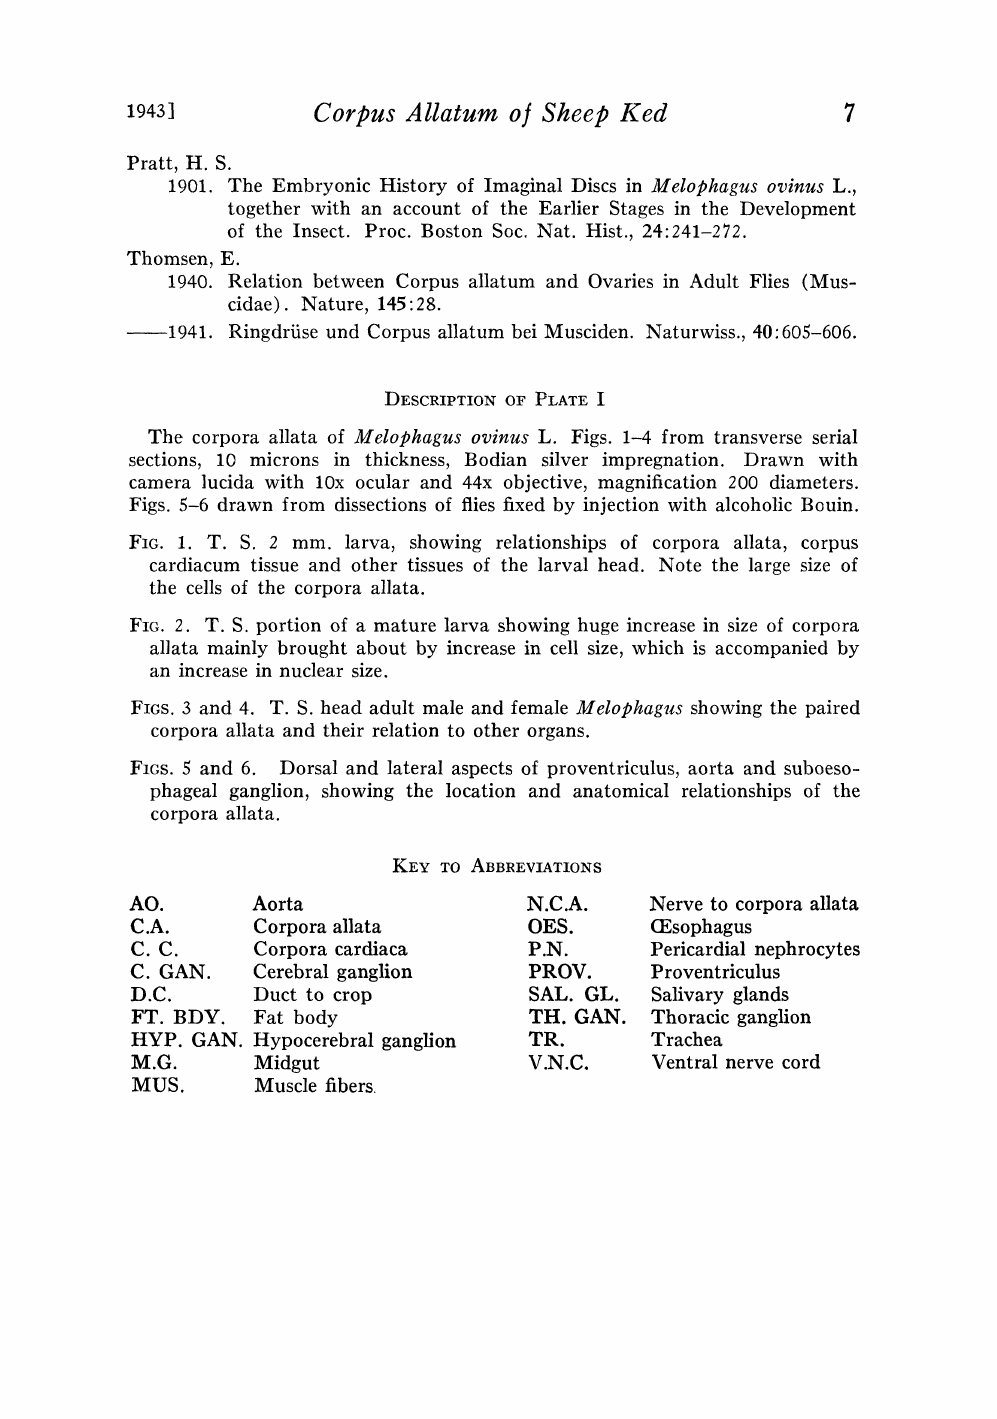
FIG. 1. T. S. 2 mm. larva, showing relationships of corpora allata, corpus cardiacum tissue and other tissues of the larval head. Note the large size of the cells of the corpora allata. FIG. 2. T. S. portion of a mature larva showing huge increase in size of corpora al|ata mainly brought about by increase in cell size, which is accompanied by an increase in nuclear size. FIGS. 3 and 4. T. S. head adult male and female Melophagus showing the paired corpora allata and their relation to other organs. FIGS. 5 and 6. Dorsal and lateral aspects of proventriculus, aorta and suboeso- phageal ganglion, showing the location and anatomical relationships of the corpora